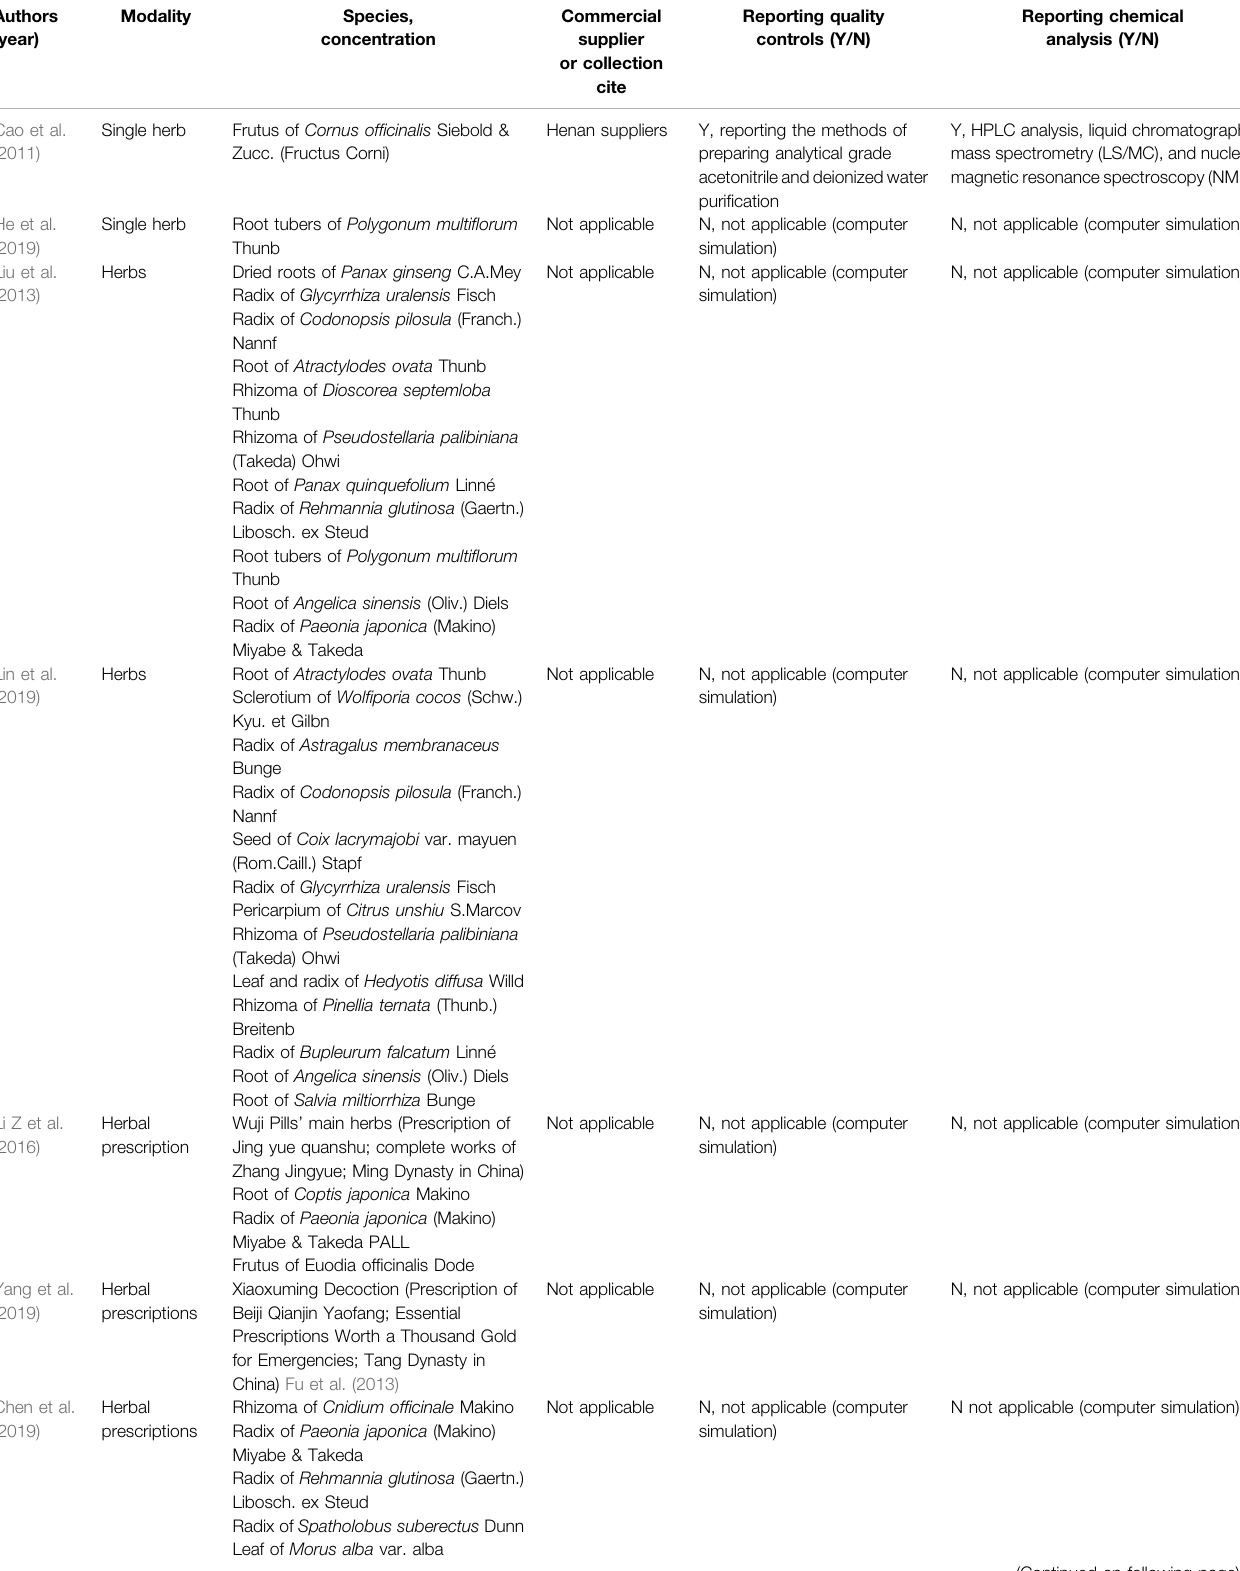
TABLE 3 | Information of herbal medicine or herb compounds in the review. Authors